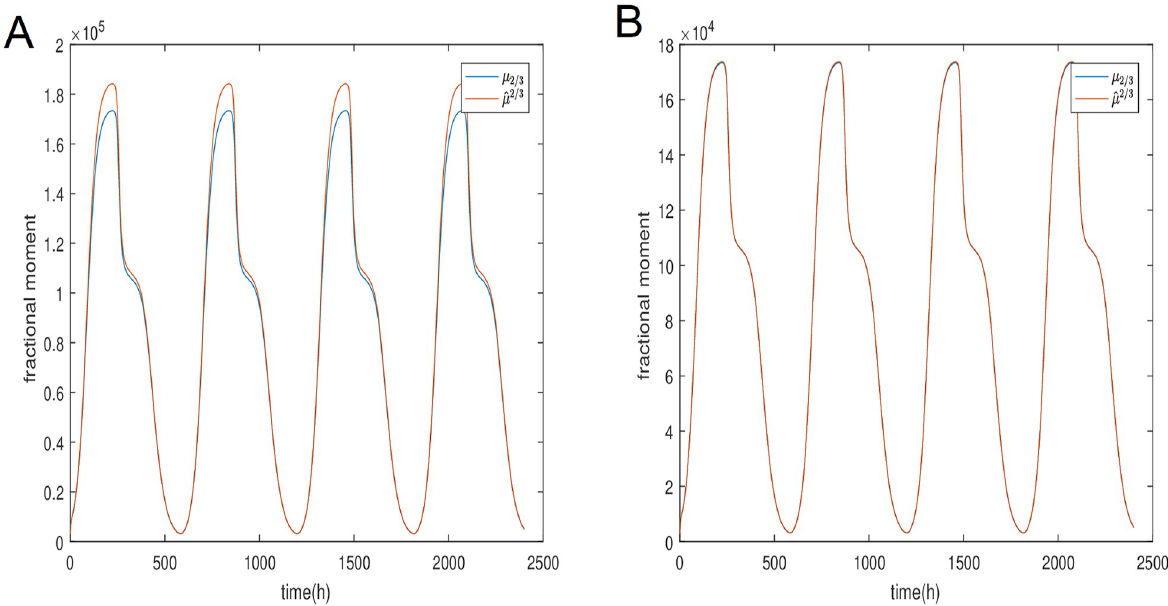
Fig 10. Comparison of the μ 2/3 fractional moment for population y derived directly from (31) and approximated from (28). (A) Comparison of two solution for the fractional moment of the y population with β = 0.01. (B) Comparison of two solution for the fractional moment of the y population with β =